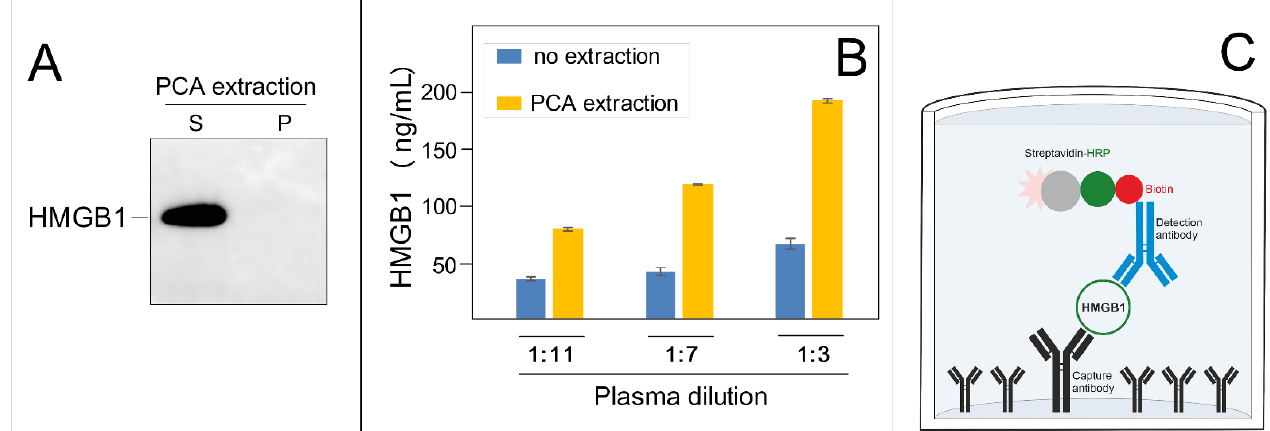
Figure 2. ( A ). Perchloric acid extraction of HMGB1 in human plasma. Left, PCA extraction of HMGB1 from human plasma (S, supernatant; P, pellet). Right, determination of HMGB1 by ELISA in plasma samples of patients before or after PCA extraction. A short protocol: one volume of human plasma was mixed in 1.5 mL Eppendorf tubes with 0.25 volume of 25% perchloric acid, vortexed, briefly centrifuged, and then neutralized with 0.5 volume of 1.5 M NaOH (relative to the volume of the plasma). Upon centrifugation, the supernatants (S) and pellets (P) were resolved on polyacrylamide gels, followed by transfer onto the PVDF membrane and detection of HMGB1 protein with specific antibody (W. blotting). ( B ). ELISA assay of HMGB1 levels in human plasma before and after PCA extraction. Human plasma, non-extracted, and PCA extracted, was diluted with PBS buffer as indicated, and the HMGB1 levels were then assayed by the sandwich ELISA. ( C ). Principle of the sandwich ELISA assay of HMGB1. A multi-well plate was coated with a polyclonal or monoclonal “capture” HMGB1 antibody. The plate was then used to immobilize HMGB1 from human plasma. The biotinylated “detection” HMGB1 antibody (a highly specific monoclonal antibody) was added to facilitate the subsequent detection using horseradish peroxidase (HRP)-conjugated streptavidin when compared with the HMGB1-calibration curve.